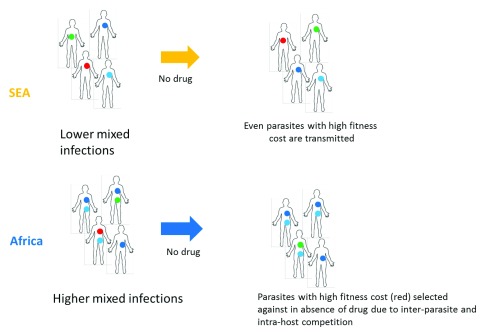
A model for the higher propensity of SEA populations to acquire drug resistance.Lower mixed infections in SEA may allow even less-fit parasites to be transmitted to next set of hosts due to reduced level of intra-host inter-parasite competition. Thus, fitness-reducing mutations including drug-resistance mutations might have a higher chance of spreading in SEA. In contrast, the higher mixed infection rate in Africa may drive more intense inter-clone competition within the host, thereby reducing the probability of transmission of the less-fit clones, including potentially drug-resistant clones. The public domain image of the outline of the human body was obtained from
https://en.wikipedia.org/wiki/File:Outline-body.png.